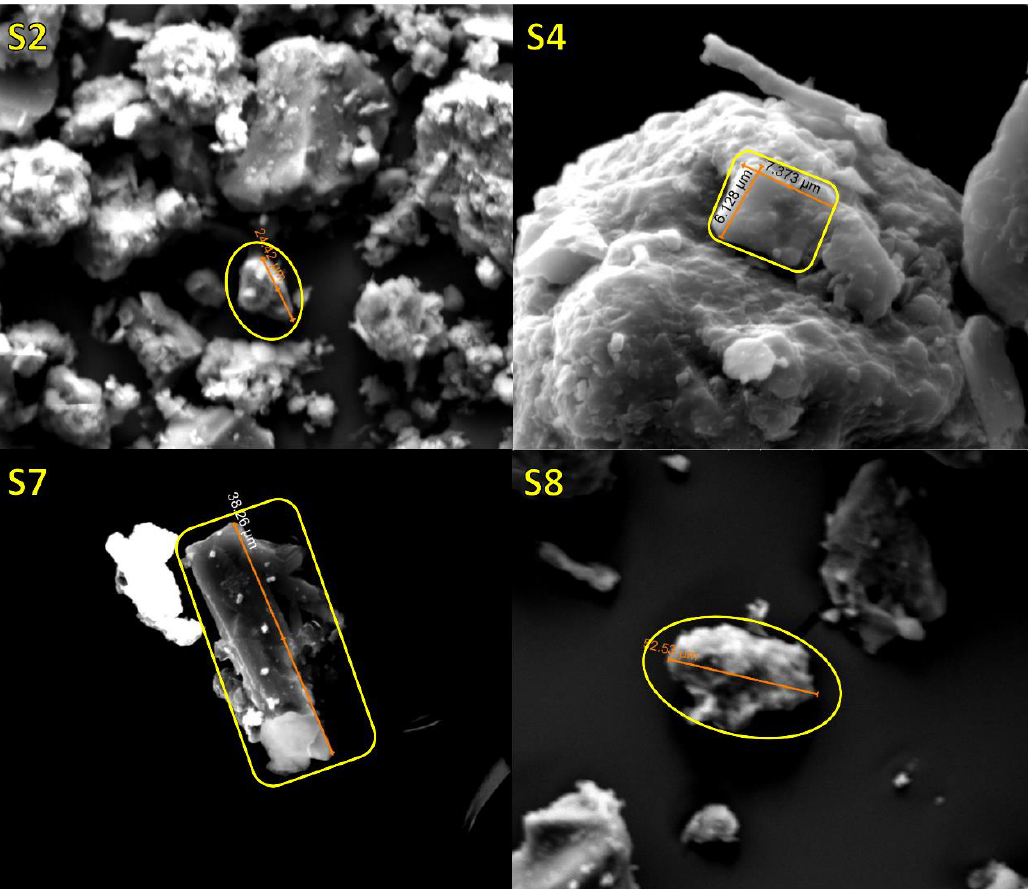
Figure 4. Representative SEM images of soil particles before extraction. The name of the corresponding soil sample is on the top-left corner of each image. Ti-containing particles detected using EDX are framed in yellow.